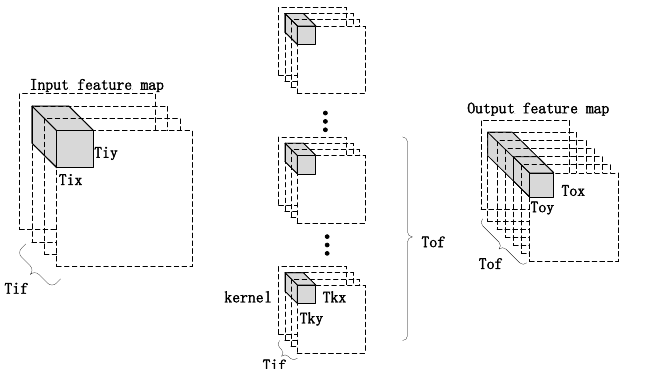
Figure 11. Loop tiling. Every time only a share of input feature map is introduced into computing. Hence, the convolution kernels are split into small slices and only a small part of output is